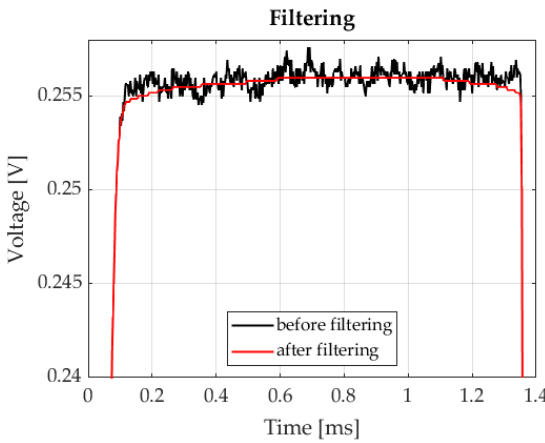
Figure 9. Signal after filtering.